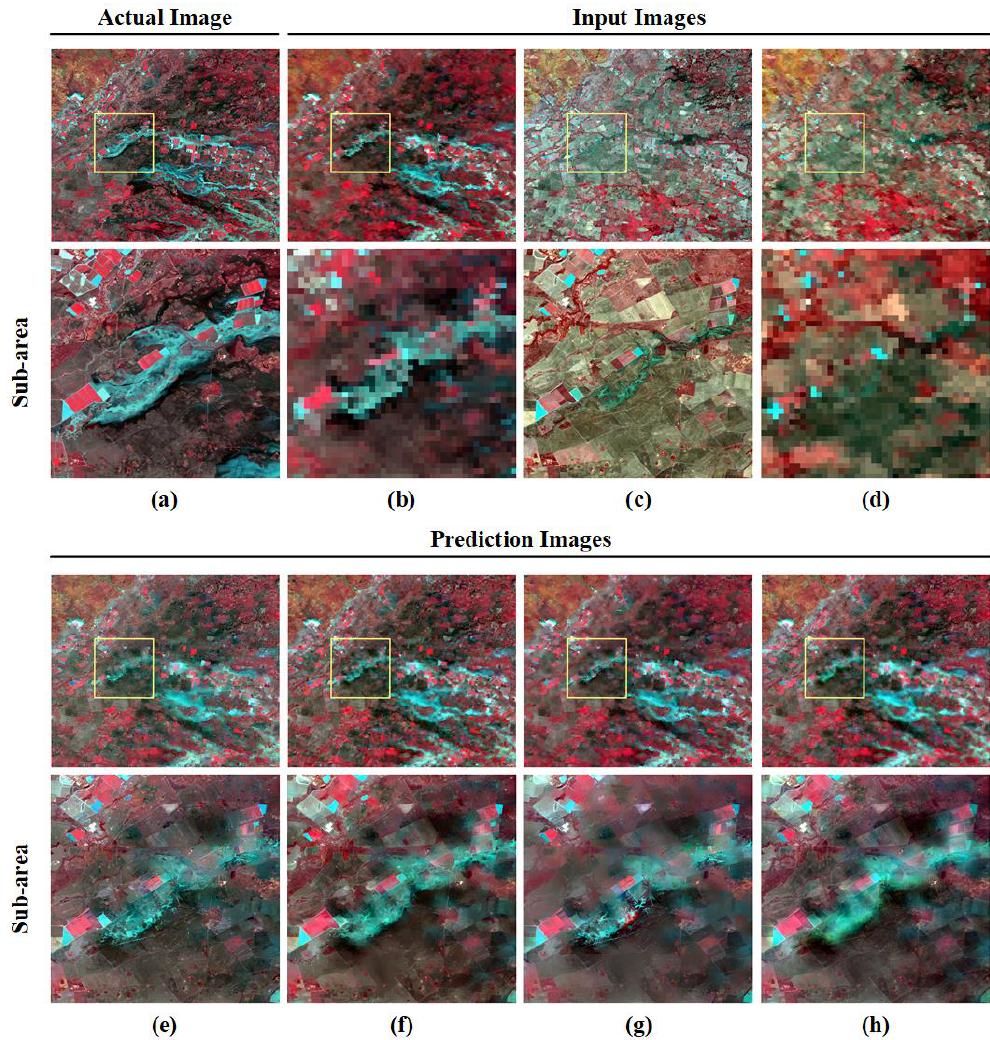
Figure 5. Visual comparison of different STF methods’ predictions for the LGC site. ( a ) Actual image. ( b ) MODIS image at the prediction date. ( c ) Landsat image at the base date. ( d ) MODIS image at the base date. ( e ) Spatial and temporal adaptive reflectance fusion model (STARFM). ( f ) Flexible spatiotemporal data fusion (FSDAF). ( g ) Fit-FC. ( h ) HDLSFM.